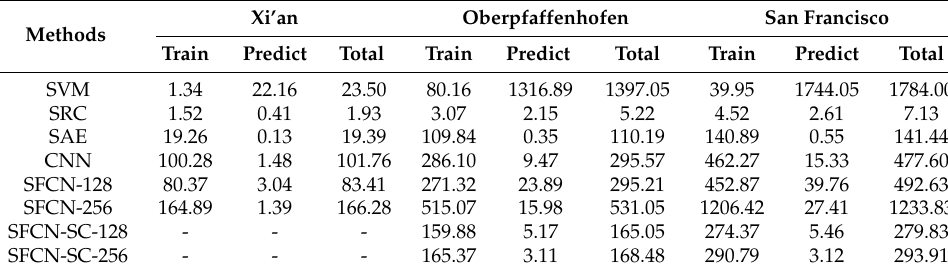
Table 7. Execution time of the three PolSAR images with different methods (S).